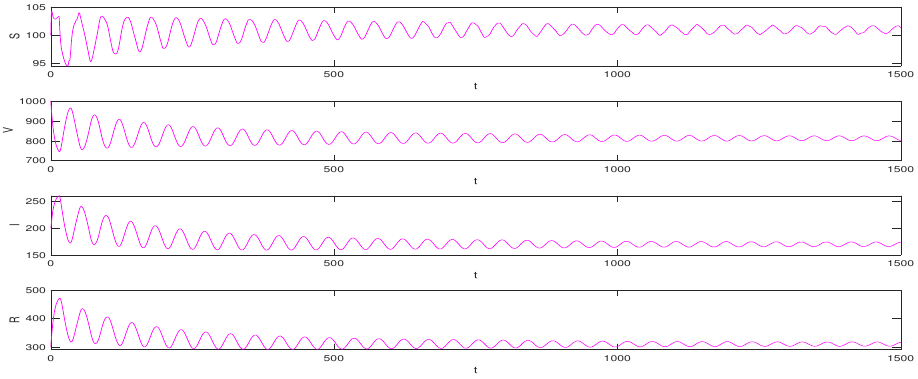
Figure 14. τ 2 ∗ = 32, τ 1 ∗ = 14.5, equilibrium E 2